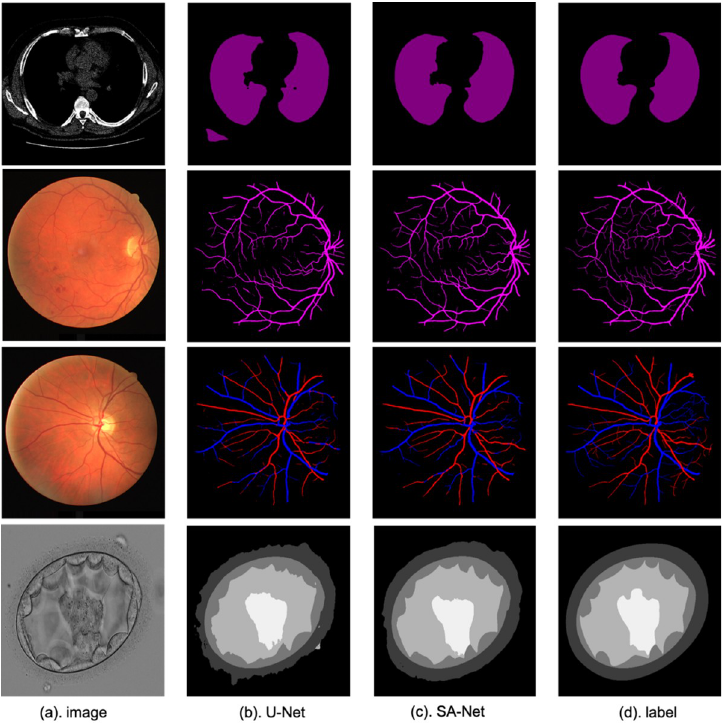
Fig 9. Example results for lung segmentation, detection of retinal blood vessels, artery/vein classification and blastocyst segmentation. From top to bottom: lung segmentation, retinal vessel detection, artery/vein classification and blastocyst segmentation.